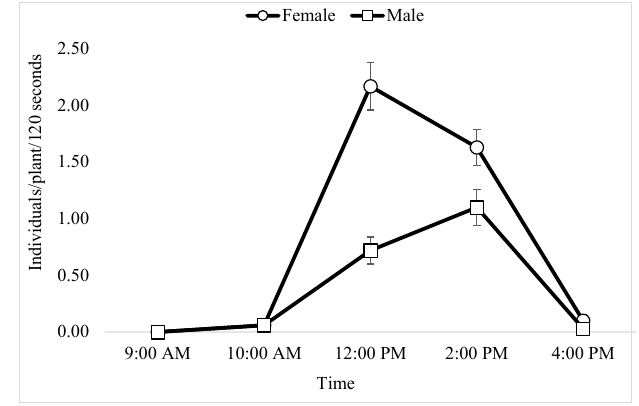
Fig 1 . Diurnal fluctuations in abundance of female and male A. savignyi